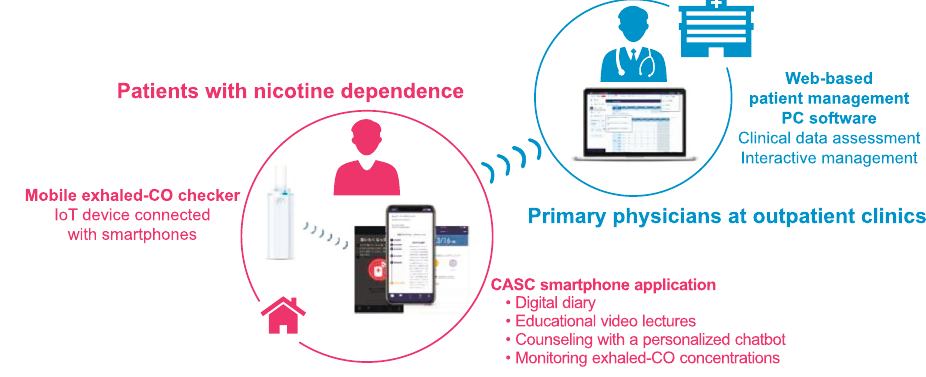
Fig. 1 Overview of the CureApp Smoking Cessation